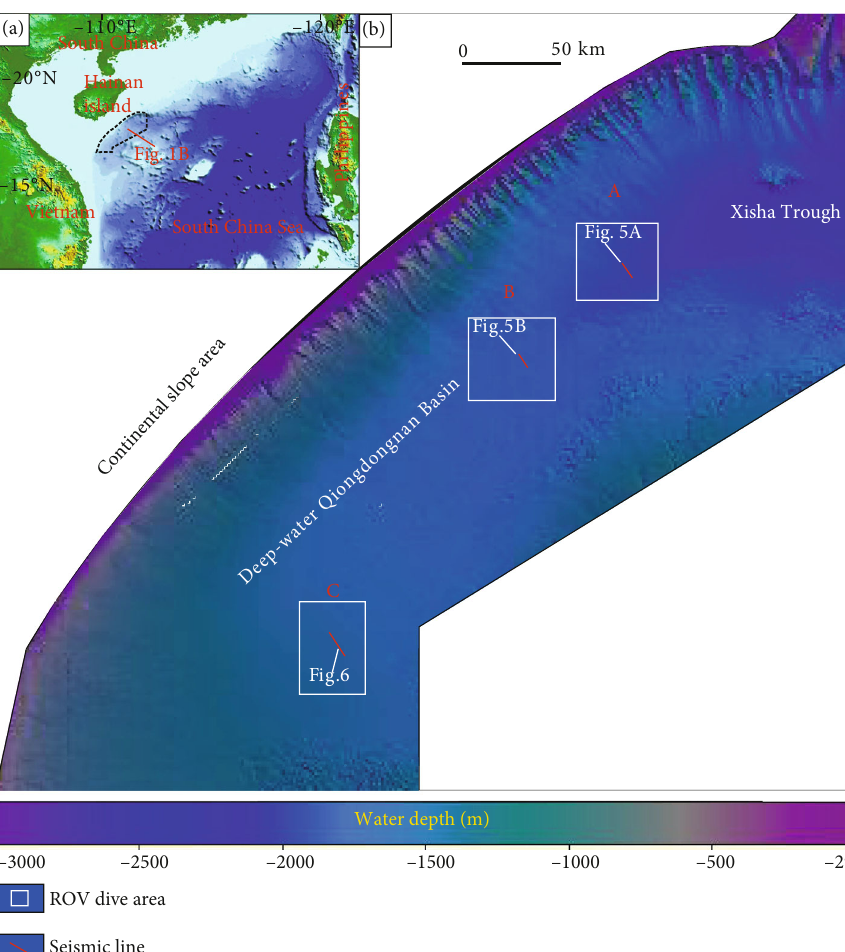
Figure 1: (a) Map of the study area in the Qiongdongnan Basin (QDNB), northern South China Sea (SCS). The QDNB lies in the western section of the continental slope in the northern SCS, with Hainan Island to the north. (b) Positions of stations A, B, and C. The white boxes represent ROV dive areas in this research. The red lines represent the seismic lines that were selected and used. The seismic line at station A extends through an inactive seep site, while those at stations B and C extend through modern cold seeps. Two evidently active cold-seep vents, HM-ROV-1 and HM-ROV-2, were located at station